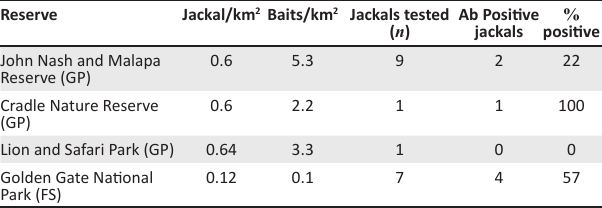
TABLE 2: Jackal population per square kilometre, bait density, number of jackals sampled after vaccination ( n ) and number of rabies antibody (Ab) positive jackals and percentage of positive jackals in three Gauteng and one Free State Reserves from 2018 to 2020, South Africa. Reserve Jackal/km 2 Baits/km 2 Jackals tested